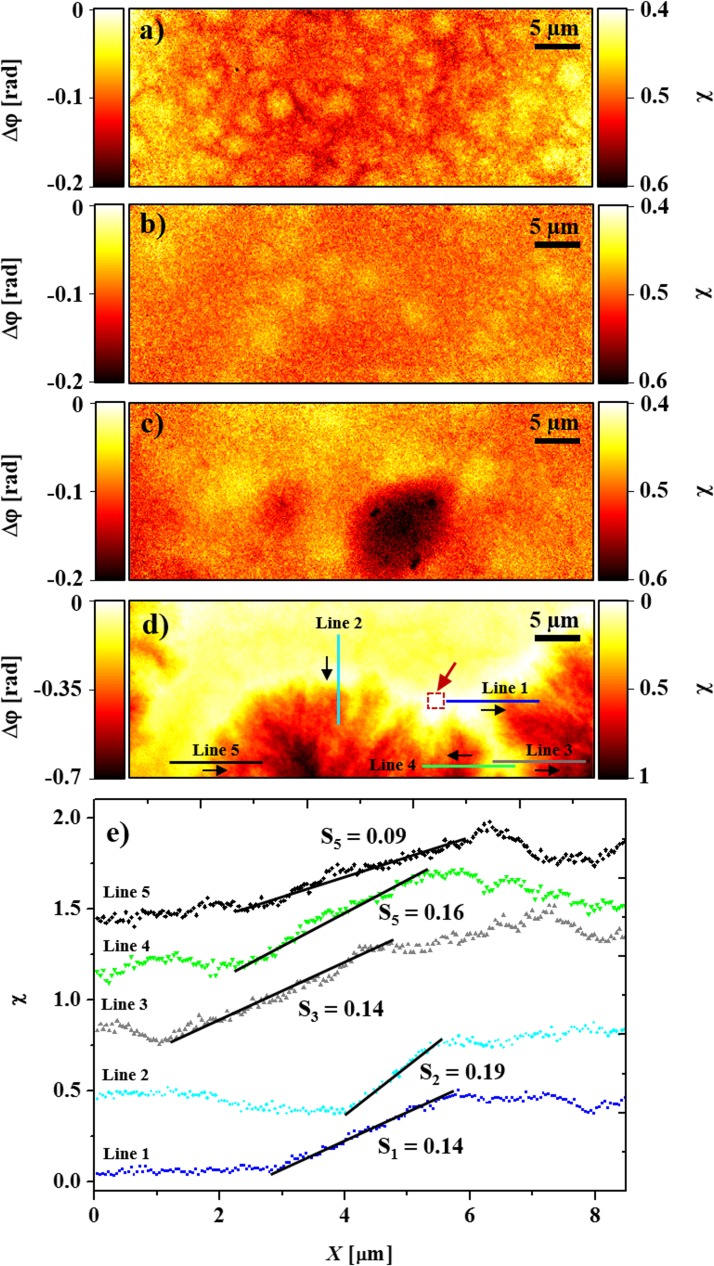
Reconstructed phase contrast high-resolution projections of P3HT/PCBM layers, all measured at room temperature.a) Non-isothermally annealed; b-d) Isothermally annealed with increasing annealing time of 60 s, 720 s and 7500 s at 127°C. e) Estimated volume fraction (χ) as a function of position estimated along the five lines indicated in d). The volume fraction gradient for the five different regions is in the range of 0.14 ± 0.05 μm-1. For readability, the curves are vertically offset. Note that the intensity scale differs between a-c) and d), as the aggregation was much more pronounced in the latter case. The red arrow in (d) indicates an area assumed to contain the lowest PCBM concentration of 4%.